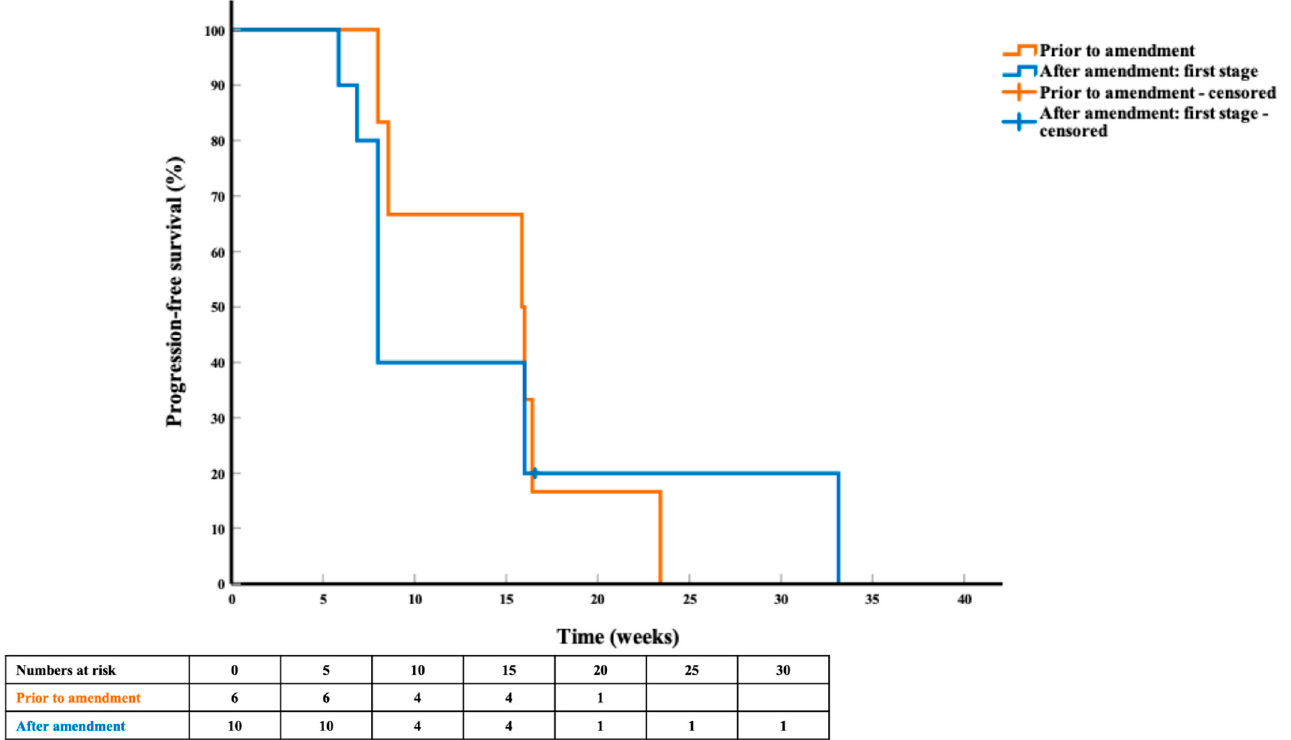
Figure 3. Progression-free survival curve and life table in the first six patients enrolled prior to trial amendment (orange) and in the ten patients enrolled after trial amendment in the first stage of the study (blue).